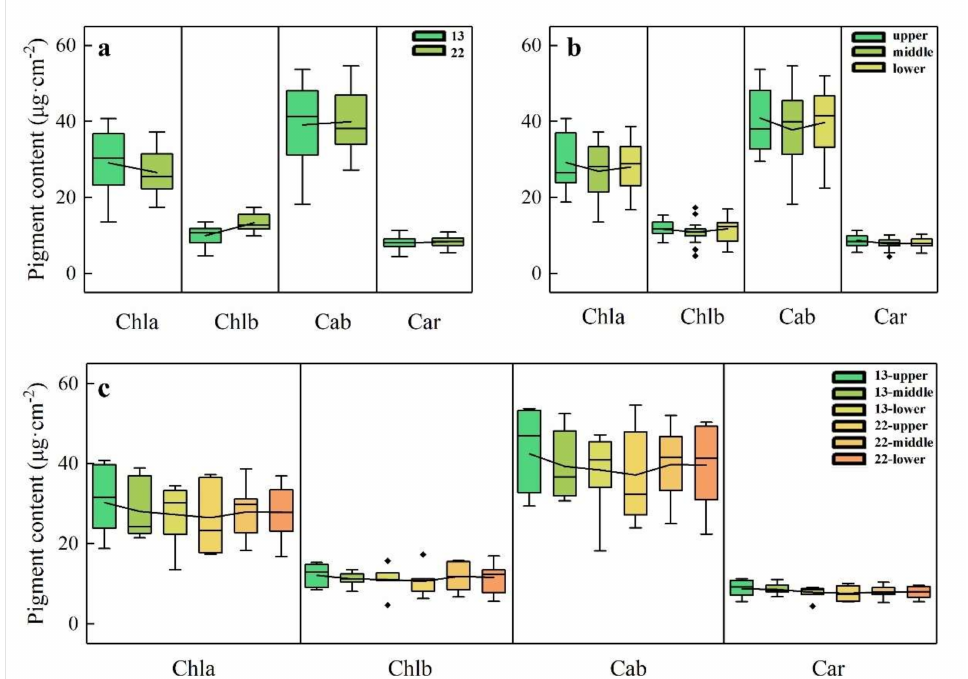
Figure 6. Box and whisker plots of the measured biochemical pigments for 42-part samples. ( a ): Box and whisker plots of biochemical pigments at different ages ( b ): Box and whisker plots of biochemical pigments at different heights; ( c ): Box and whisker plots of biochemical pigments at different heights under different ages. Note: Chla = chlorophyll a content ( µ g · cm − 2 ); Chlb = chlorophyll b content ( µ g · cm − 2 ); Cab = total chlorophyll content ( µ g · cm − 2 ); Car = carotenoids content ( µ g · cm − 2 ); 13 = 13-year-old part samples; 22 = 22-year-old part samples; upper = upper vertical samples; middle = middle vertical layer; lower = lower vertical samples; 13-upper = 13-year-old upper samples; 13-middle = 13-year-old middle samples; 13-lower = 13-year-old lower samples; 22-upper = 22-year- old upper samples; 22-middle = 22-year-old middle samples; 22-lower = 22-year-old lower